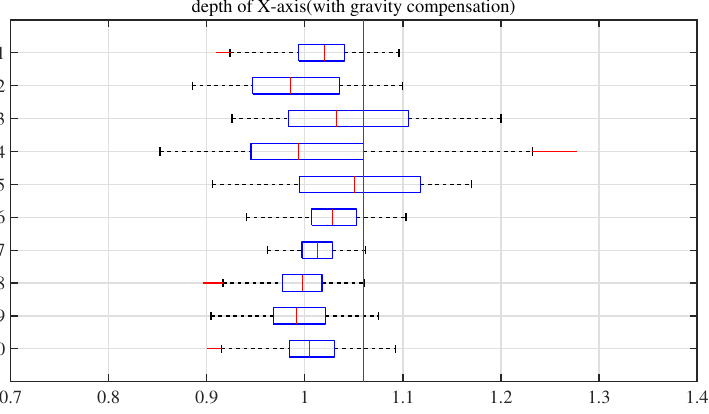
Figure 19. Distribution of the UW end-effector depth in x-axis of 10 subjects without gravity compen- sation of K-handler.